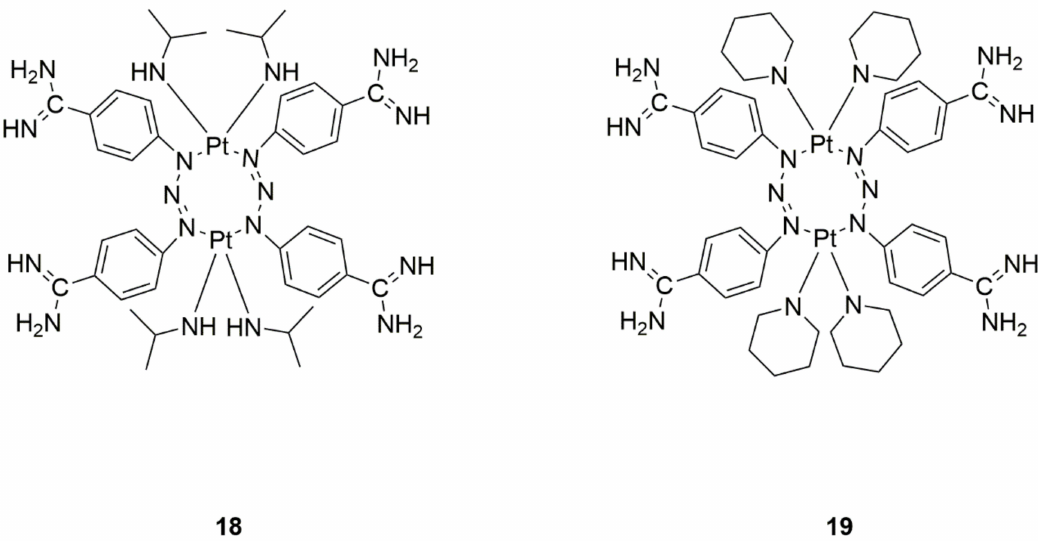
Figure 9. Structures of berenil-platinum(II) complexes ( 18 —Pt 2 (isopropylamine) 4 berenil 2 and 19 —Pt 2 (piperidine) 4 (berenil) 2 ).